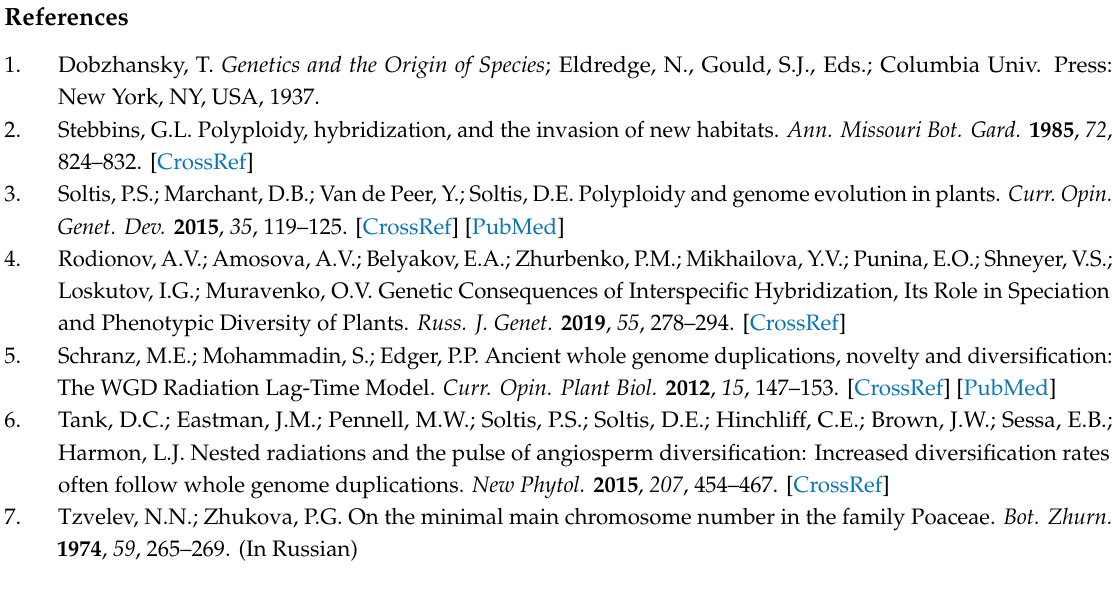
Table S1: Taxon names, GenBank accession numbers and sources of the ITS sequences used in this